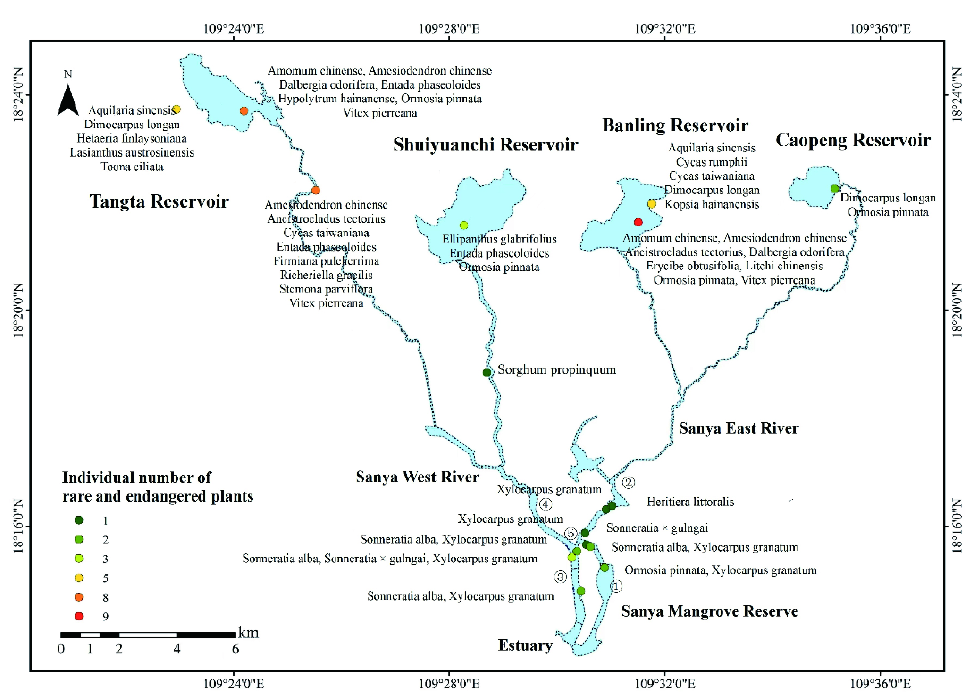
Figure 3. Locations of rare and endangered plants in the Sanya River Basin, Hainan Province, China;